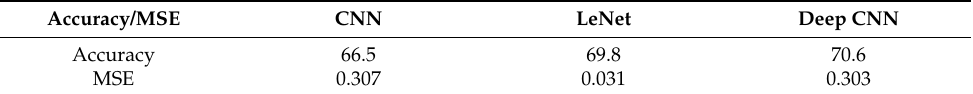
Table 6. Accuracy and Loss Comparison of CNN, LeNet, and Deep CNN Models on the Combined Pashto Digit and Character Dataset.